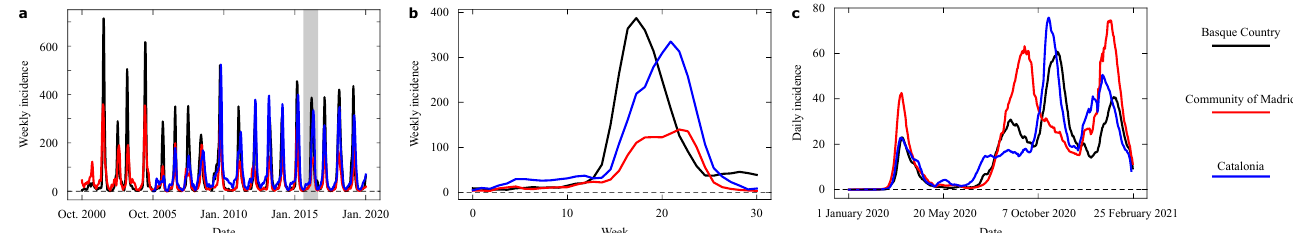
Figure 1. Empirical time series of the influenza and SARS-CoV-2 epidemics. ( a ) Examples of historical time series of flu over 20 years in three Spanish regions: Basque Country (black), Community of Madrid (red), and Catalonia (blue). Data from each year (spanning from week 40 of a given year to week 20 of the next year) have been concatenated omitting the warm season (during which incidence is negligible). The gray area is expanded in ( b ) to show the yearly exponential raise, peak, and fall that characterizes the influenza cycle. Here, is data from 2015/16. ( c ) Evolution of the SARS-CoV-2 pandemics in the same three regions shows the pattern of waves within a single year, which are not always in phases across